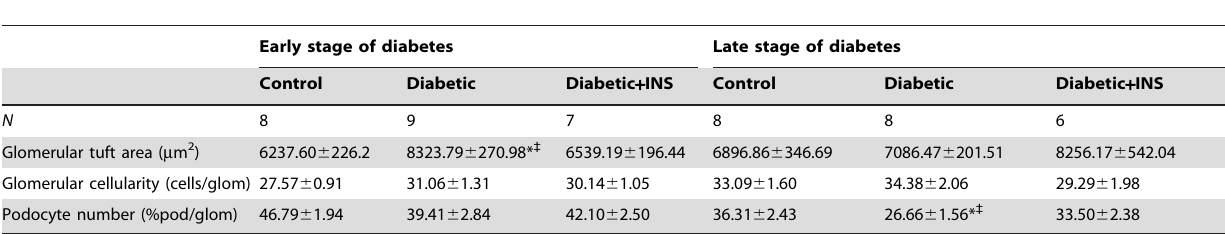
Table 2. Morphometric analysis for NOD diabetic mice (Diabetic), NOD diabetic mice treated with insulin (NOD + INSULIN) and NOR control mice